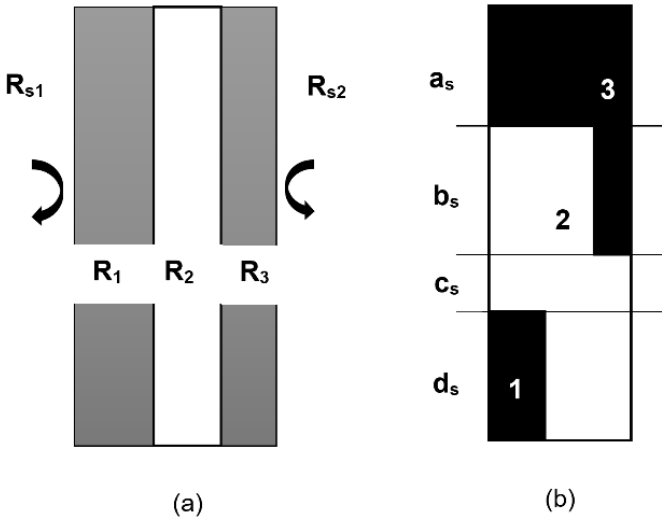
Figure 2. Heat transfer through walls: ( a ) Wall with heterogeneous layers; ( b ) Wall with non-homogeneous materials.